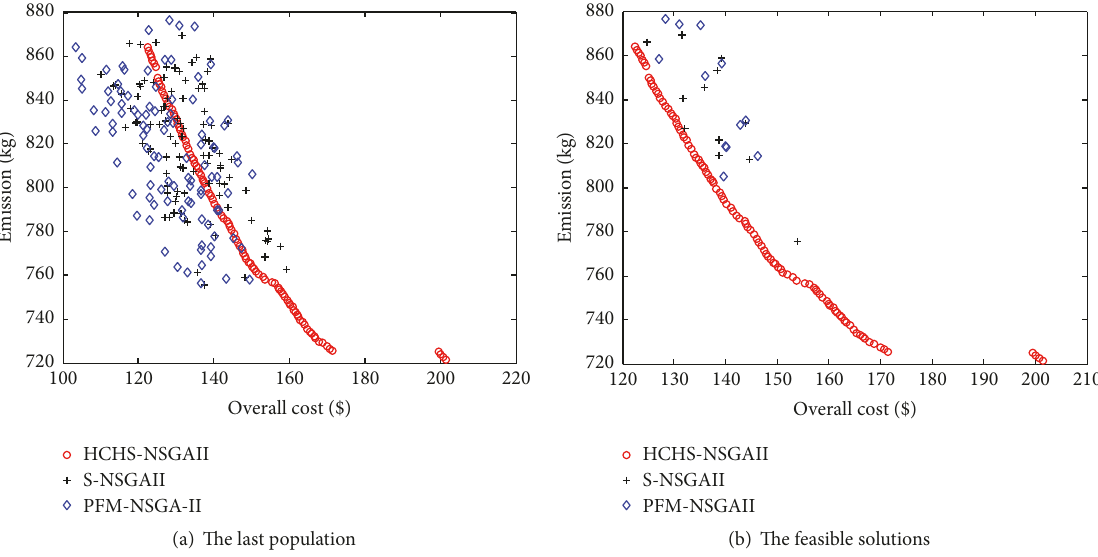
Figure 6: The best optimization results by HCHS-NSGAII, S-NSGAII, and PFM-NSGAII in Scenario Three.